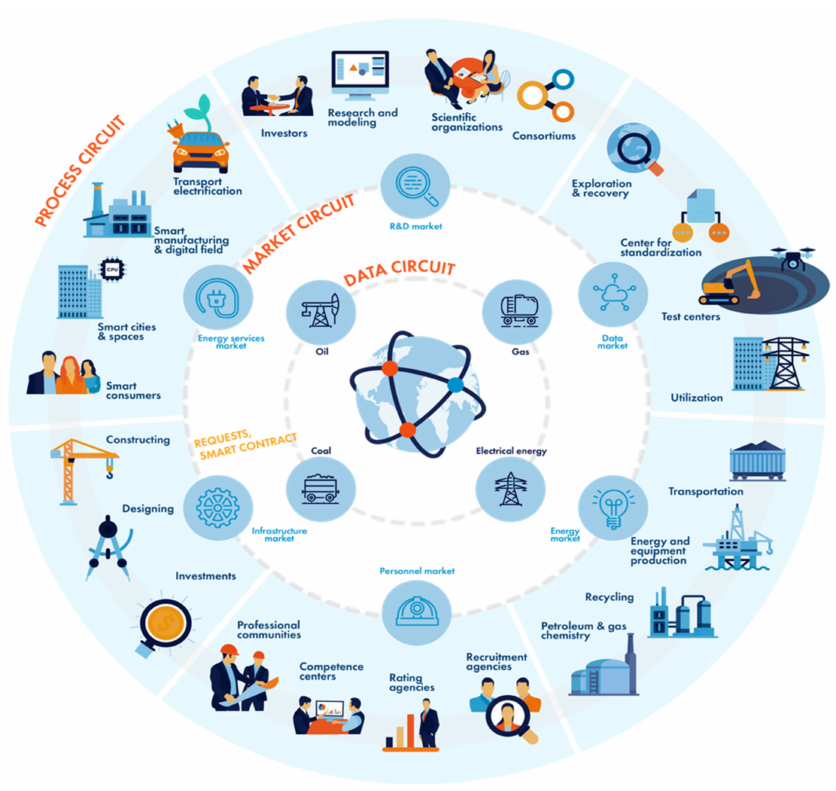
Figure 8. The digital platform, “transformation of the energy sector for sustainable